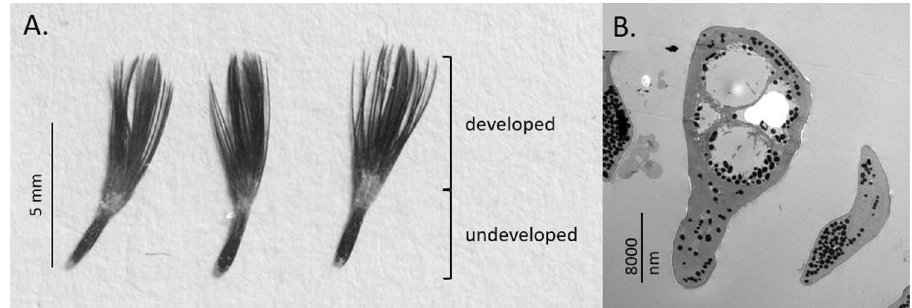
Figure 4. House sparrow feathers sampled from bib after three weeks of the experiment. Feathers during development ( A ), a TEM cross-sections of feather sampled from bib after the experiment ( B